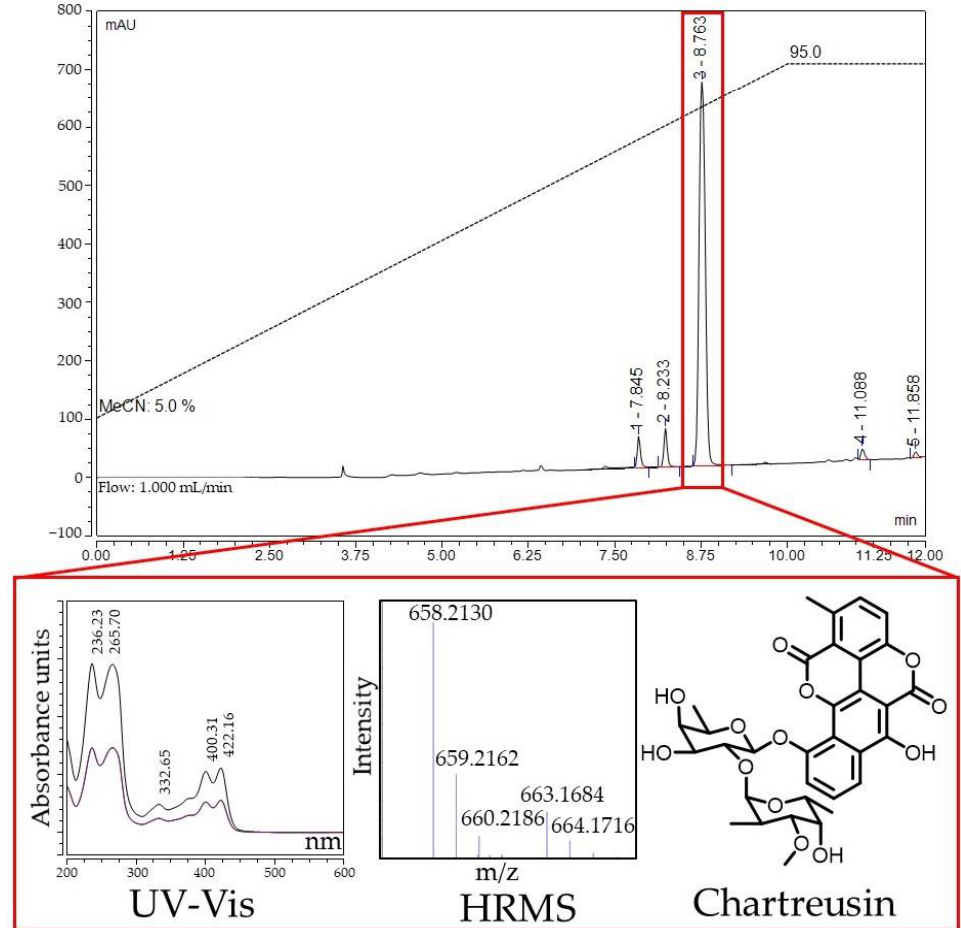
Figure 8. HPLC analysis of the active fraction of Streptomyces sp. BV113 culture liquid. Elution with 5 → 95% MeCN in water for 10 min followed by 2 min of 95% MeCN. Red box indicates the active component on the HPLC profile.